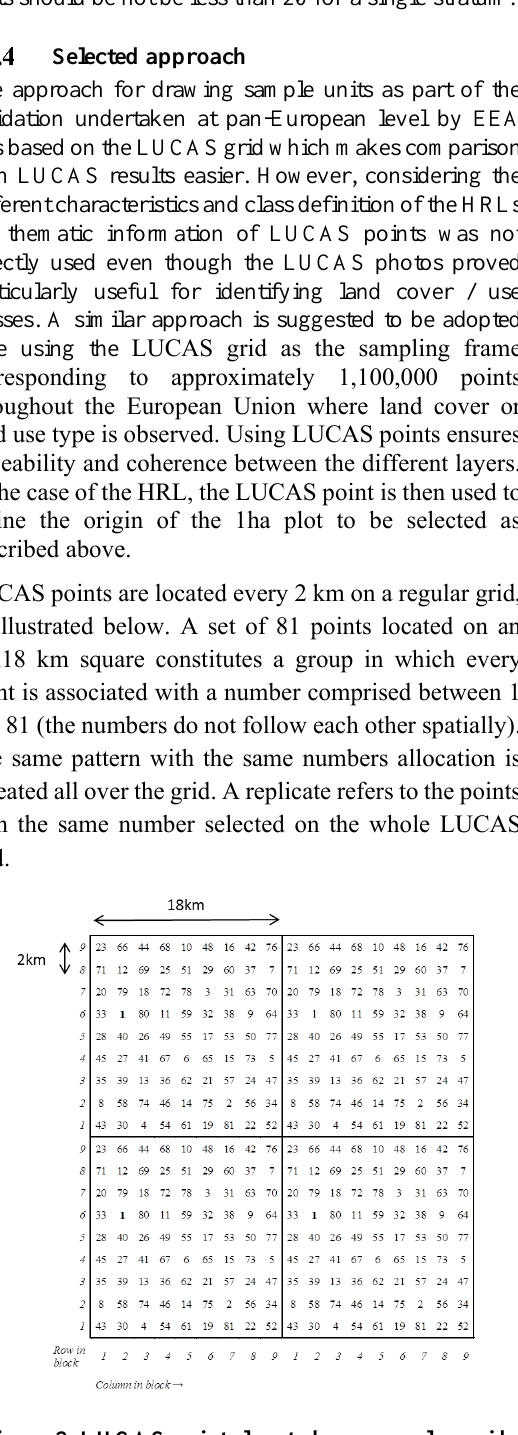
Figure 2. LUCAS points located on a regular